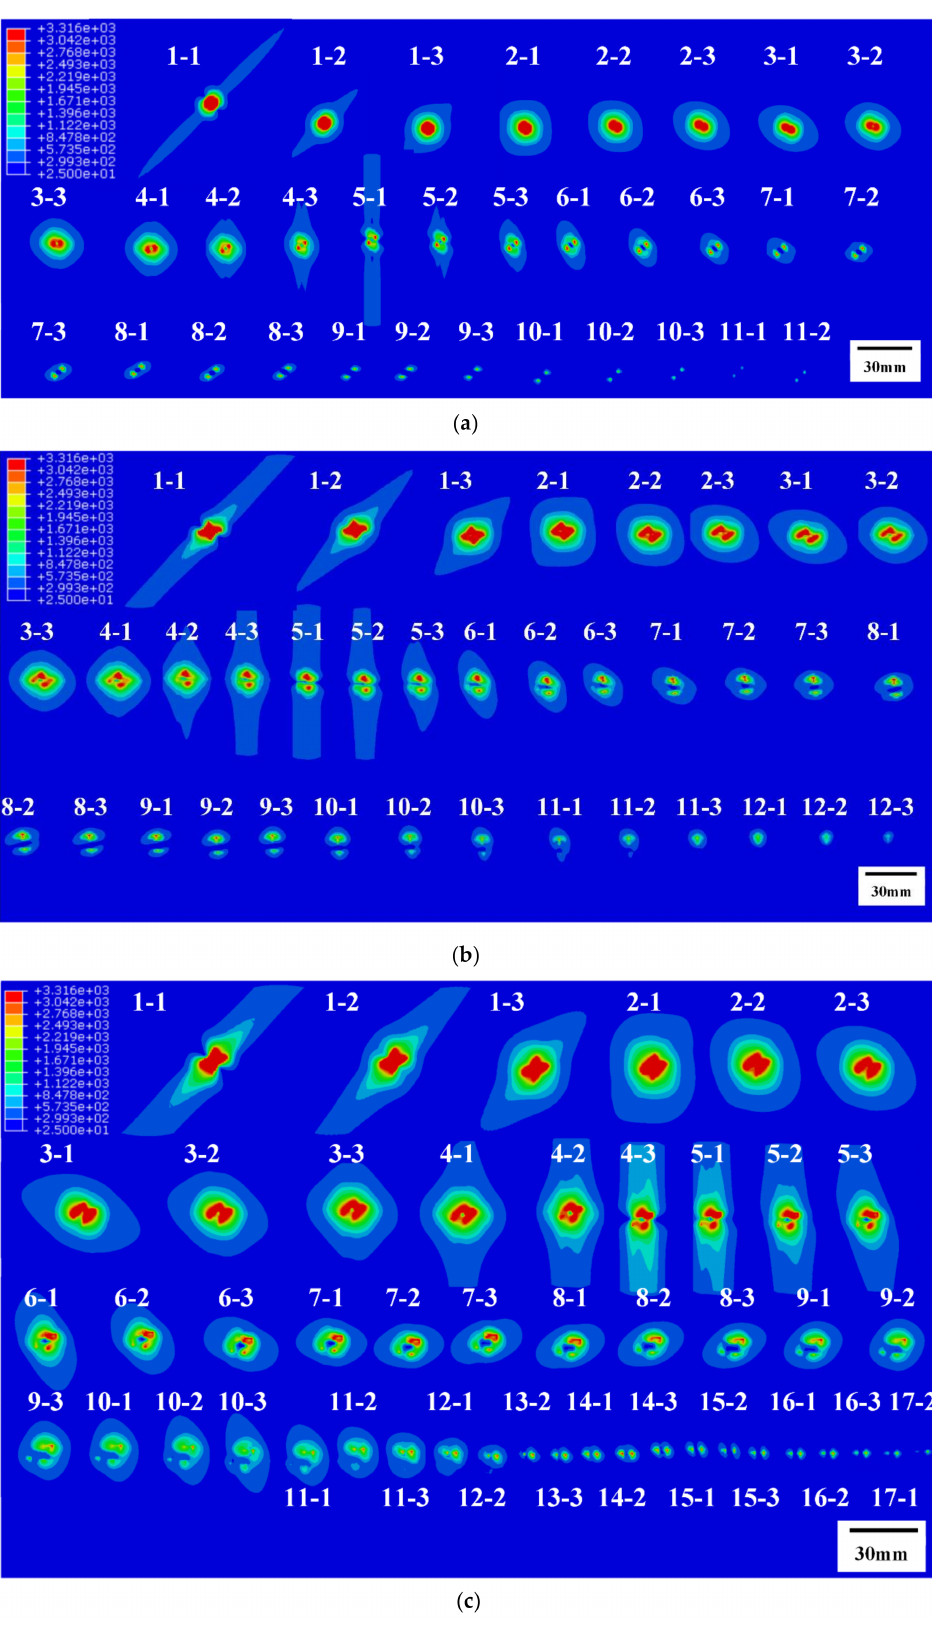
Figure 8. Tomography images’ summaries of di ff erent FEA models in Group A: ( a ) the A20s; ( b ) the A40s; ( c ) the